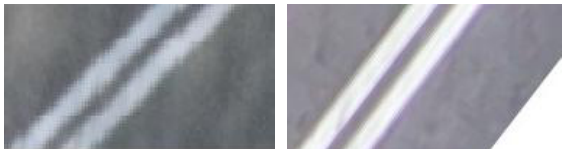
Figure 11. Zoom and comparison of images taken from the aircraft (left) and UAV (right) for the same area on the road But on the other hand both images (figure 12) after use of Laplace'a filter looks similar at first glance, but on the left image we see wider edges than on the right image. Wider edges shows more noise in image. It is proof of above statement.